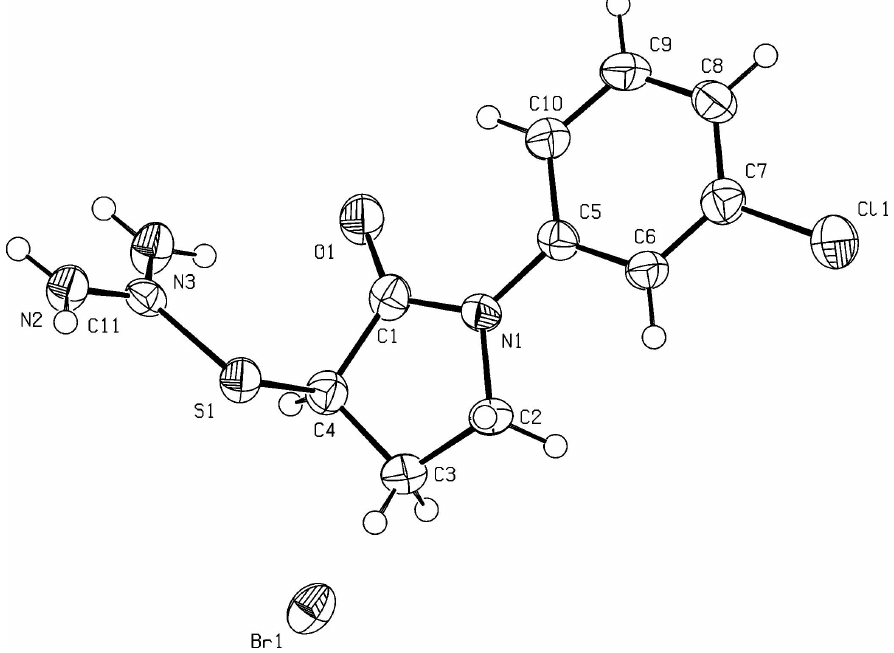
View of the title molecule with the displacement ellipsoids shown on 50% probability level. The H atoms are shown with arbitrary